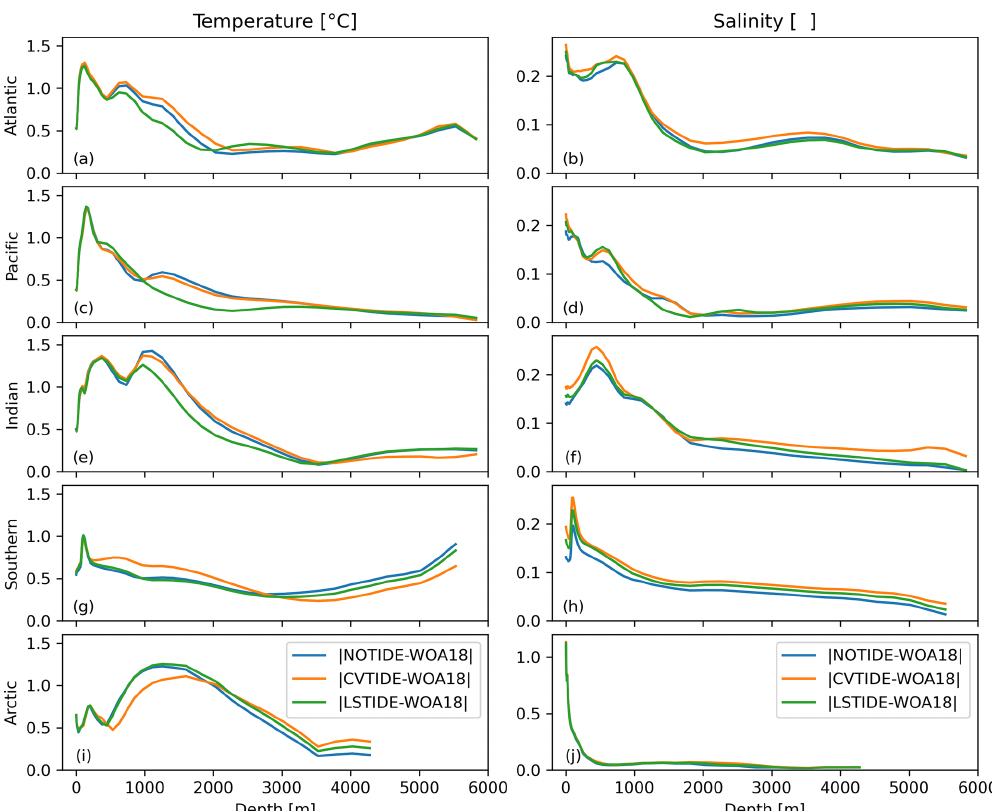
Figure 3. Basin-averaged hydrographic biases between the model results and WOA18 with respect to water depths. The hydrographic biases are absolute values. Panels (a) , (c) , (e) , (g) and (i) and panels (b) , (d) , (f) , (h) and (j) represent temperature and salinity biases, respectively, while each row shows the biases in different basins. The averaging is